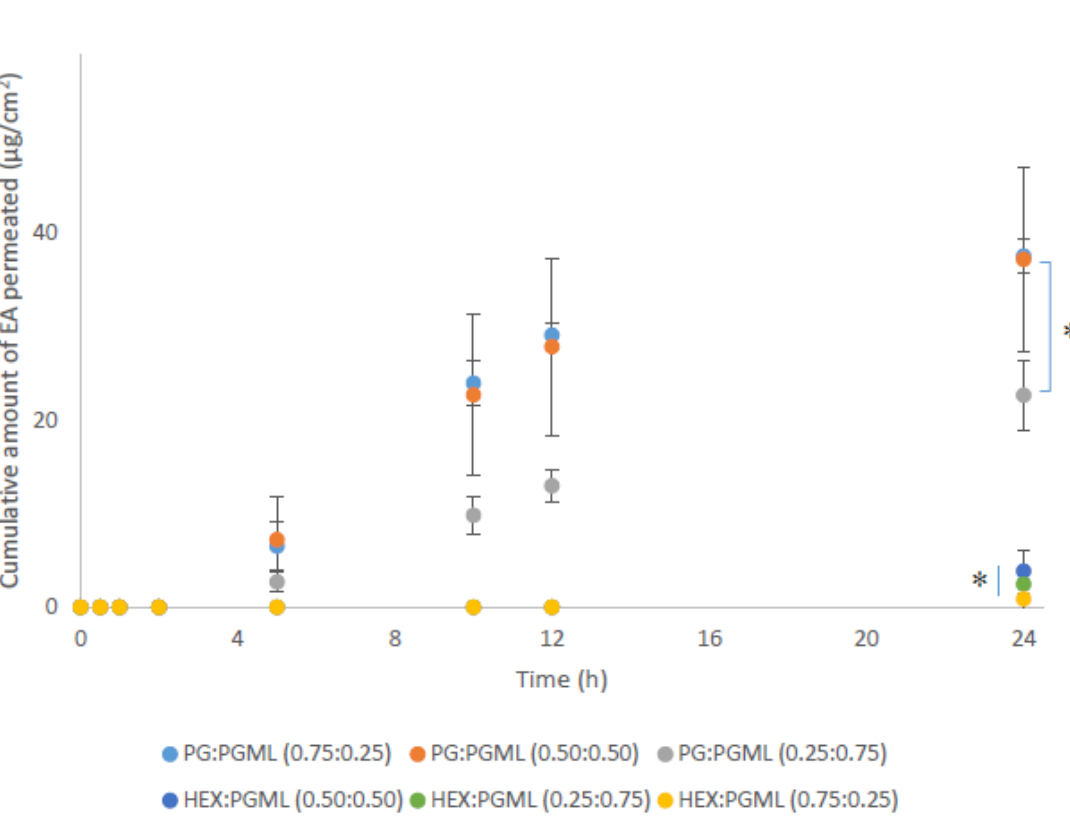
Figure 2. Cumulative permeation of 3-O-ethyl l-ascorbic acid over time for various PG:PGML and HEX:PGML solvent systems ( n ≥ 3; mean ± SD, * p < 0.05).